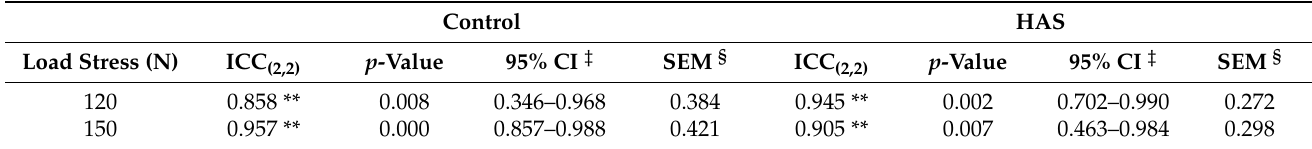
Table 1. Inter-rater reliability of the ultrasound stress test calculated by the ICC (2,2) model † . Control HAS